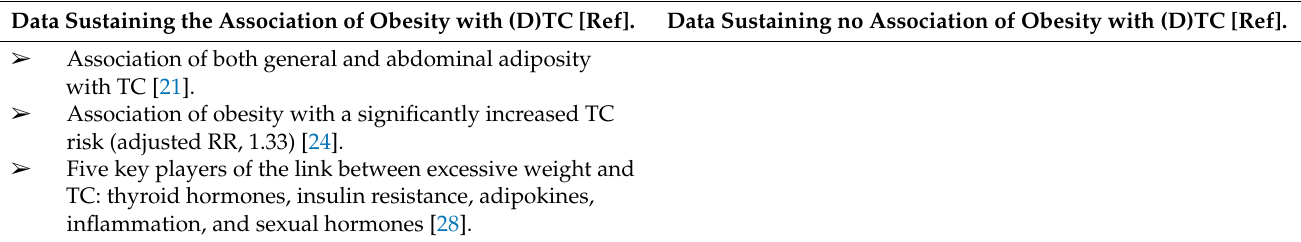
Table 1. Cont. Controversy over the Association of Obesity with (D)TC Data Sustaining the Association of Obesity with (D)TC [Ref]. Data Sustaining no Association of Obesity with (D)TC